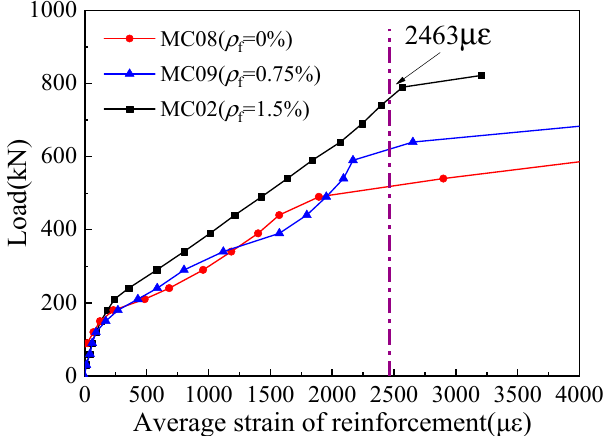
Figure 9. Relationship between load and average strain of longitudinal reinforcement under different ρ f